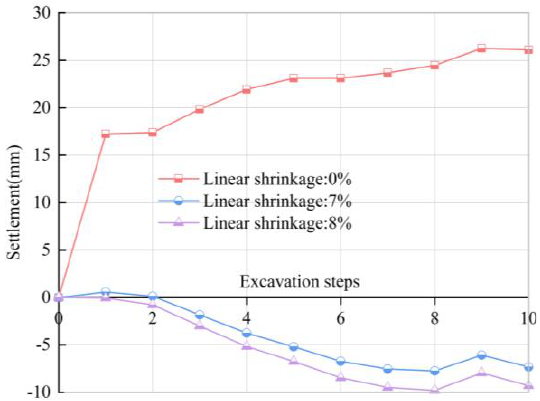
Figure 15. Influence of linear shrinkage rate on the longitudinal deformation of the ground sur- face.